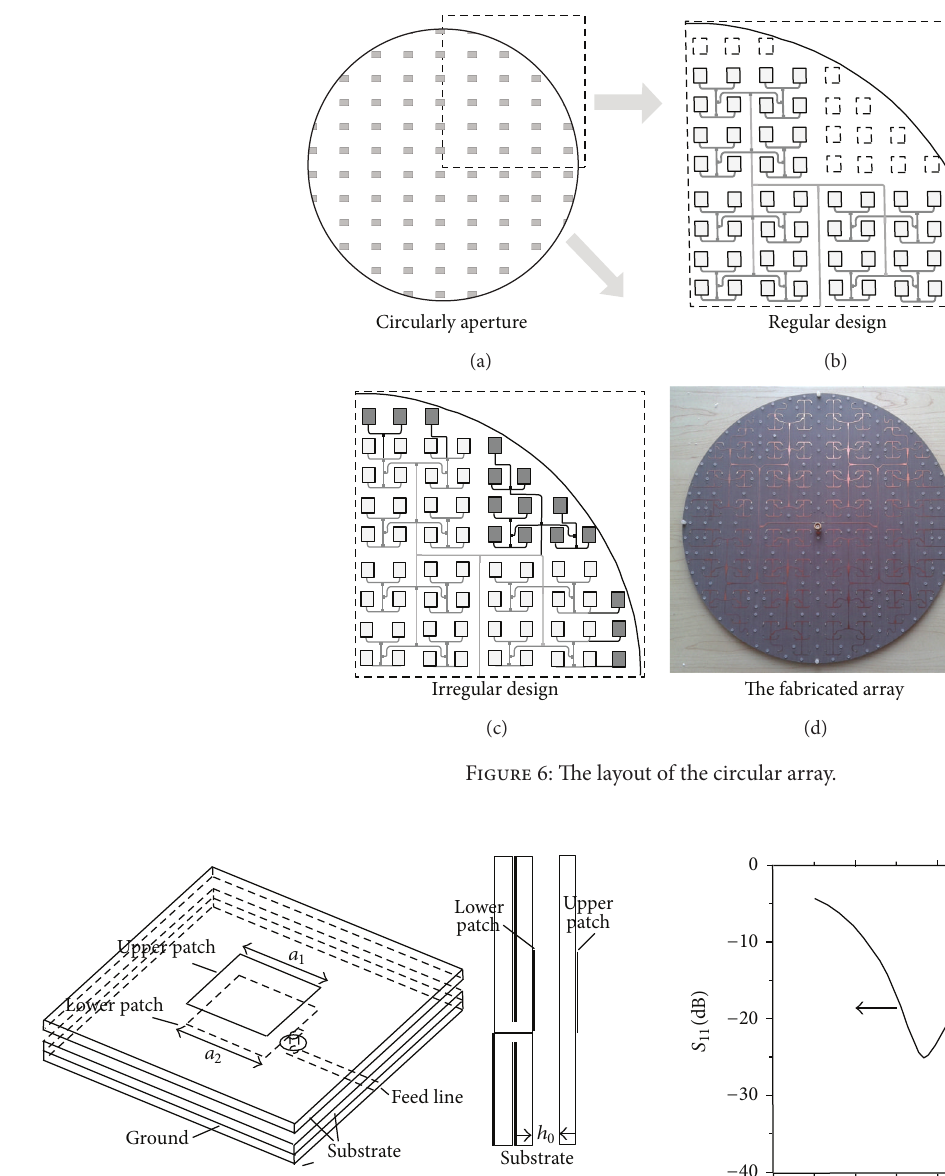
Figure 7: The array element design.